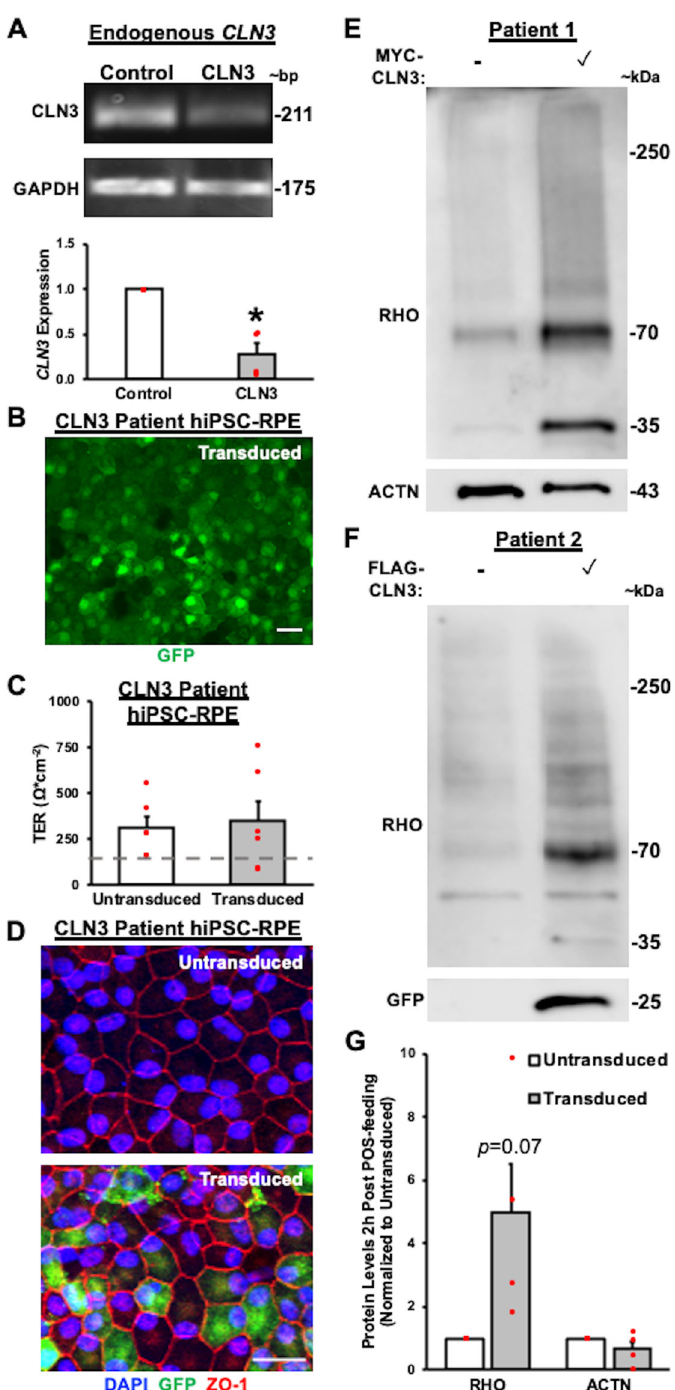
hiPSC characterization . Immunocytochemical analyses were performed to con- fi rm the expression of known pluripotency markers, OCT4 and NANOG, in all control and CLN3 disease hiPSC lines (Supplementary Fig. 11). Furthermore, both PCR analyses and gel electrophoresis (Supplementary Fig. 11) and DNA sequen- cing (Supplementary Fig. 12) using previously published primers (Forward: 5 ′ - CATTCTGTCACCCTTAGAAGCC-3 ′ ; Reverse: 5 ′ -GGCTATCAGAGTCCA- GATTCCG-3 ′ ) 89 were utilized to con fi rm the absence and presence of the 966 bp homozygous gene deletion spanning exon 7 and 8 in control versus CLN3 disease hiPSCs respectively. Standard karyotyping analysis was also carried out to con fi rm chromosomal integrity of all hiPSC lines (Supplementary Fig. 11). hiPSC culture and differentiation . hiPSCs were cultured on either irradiated mouse embryonic fi broblast (Thermo Fisher Scienti fi c) feeder layer in hiPSC basal